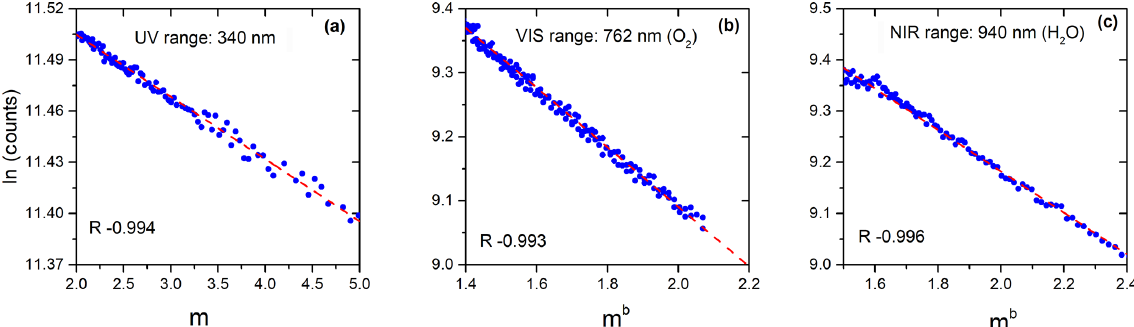
Figure 7. Examples of Langley plots using the UV–VIS near-IR direct Sun measurements on 19 March 2019 at the Izaña Atmospheric Observatory at (a) 340nm, (b) 762nm (O 2 ), and (c) 940nm (H 2 O)nm. R : correlation coefficient.